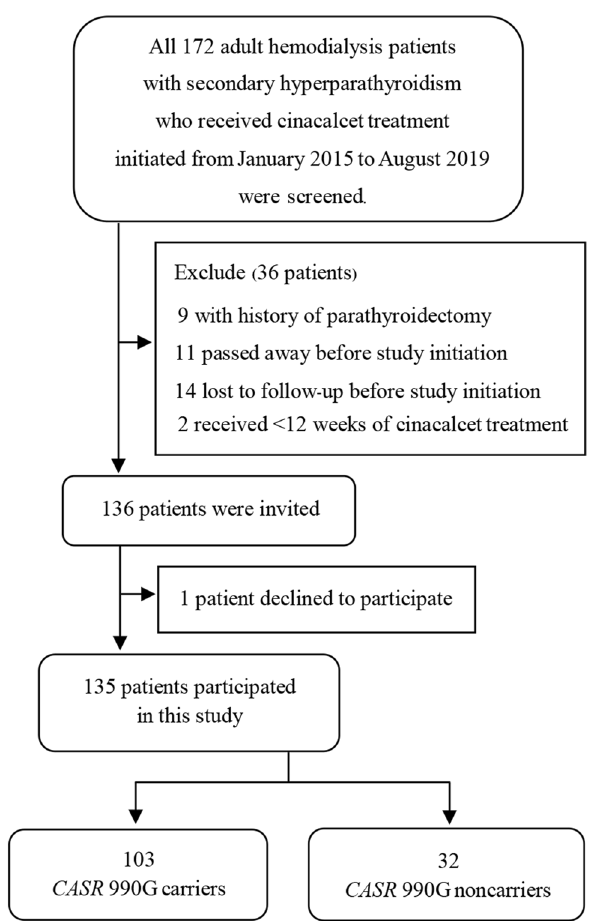
Figure 1. Flow diagram of the inclusion and exclusion